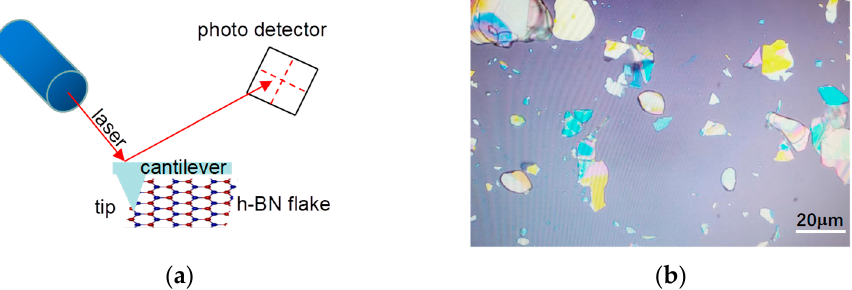
Figure 3. ( a ) Schematic diagram of h-BN flake topography measurements by using AFM. ( b ) Optical images of h-BN observed by different contrasts between the substrate and the sample.